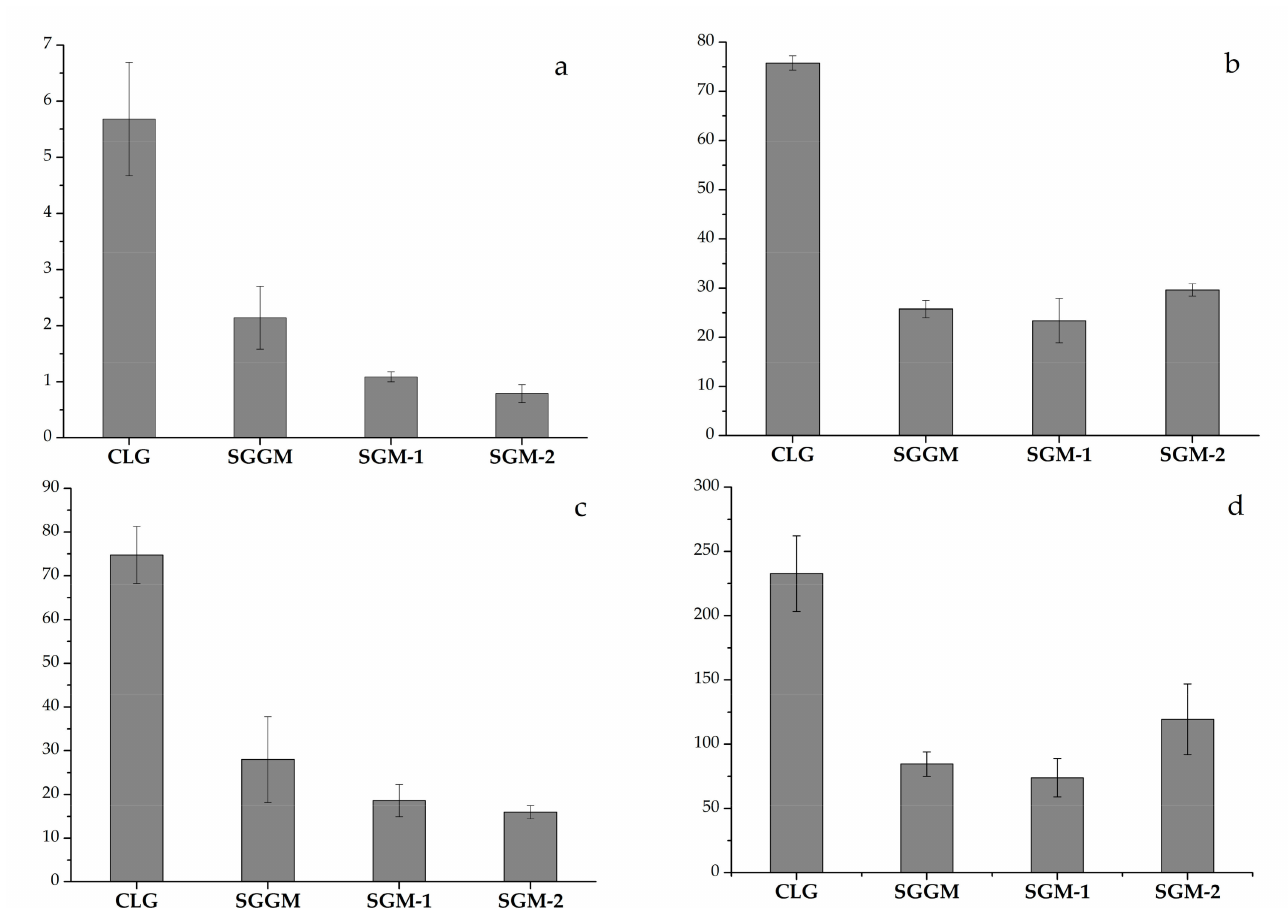
Figure 5. Effect of GGM/GM sulfates (1.67 mg/mL) on the collagen-induced human platelet ag- gregation ( n = 4). ( a ) Lag phase in the platelet aggregation curve, min; ( b ) platelet aggregation, %; ( c ) slope of the platelet aggregation curve, rel. units/min; and ( d ) area under the platelet aggregation curve, rel. units ×